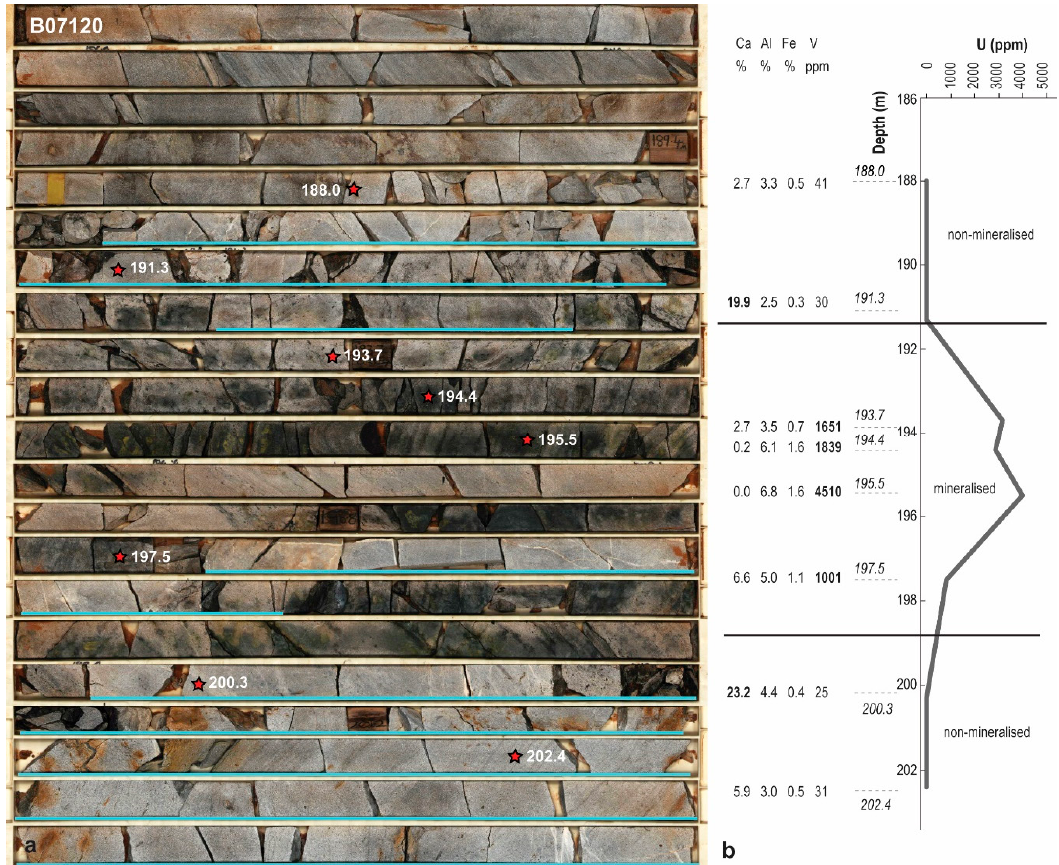
Figure 6. ( a ) Hole B07120 (A4) drill core imagery over a U-V-mineralized; ( b ) interval showing pXRF measurements at selected points between 188.0 and 202.4 m depths. Dark sandstone of sooty appearance in drill core is typical of V mineralization.